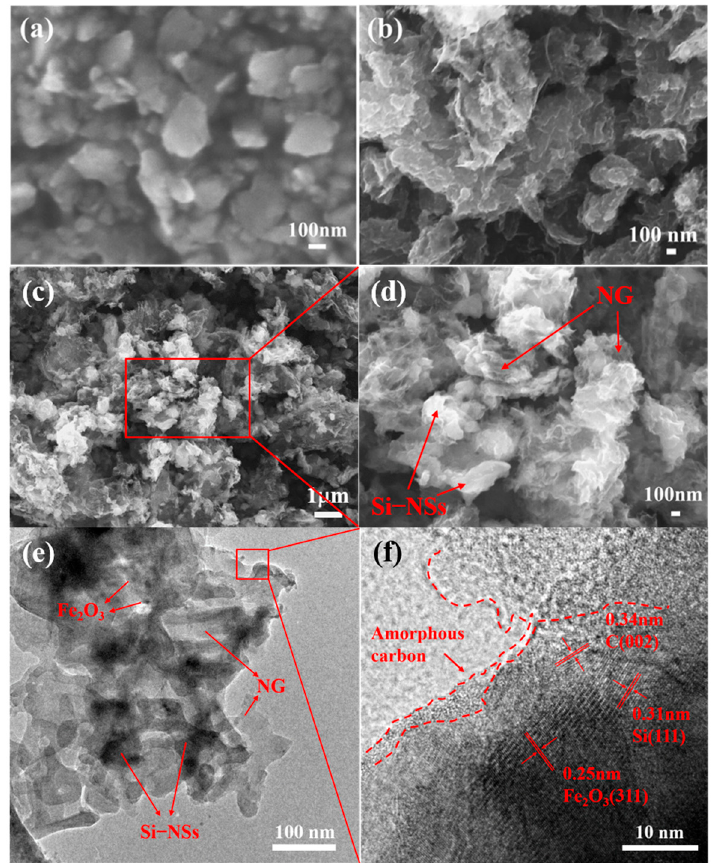
Figure 1. SEM images of Si–NSs ( a ); NG ( b ); Si–NSs@C/NG ( c , d ); TEM image ( e ) and HRTEM image ( f ) of Si–NSs@C/NG.